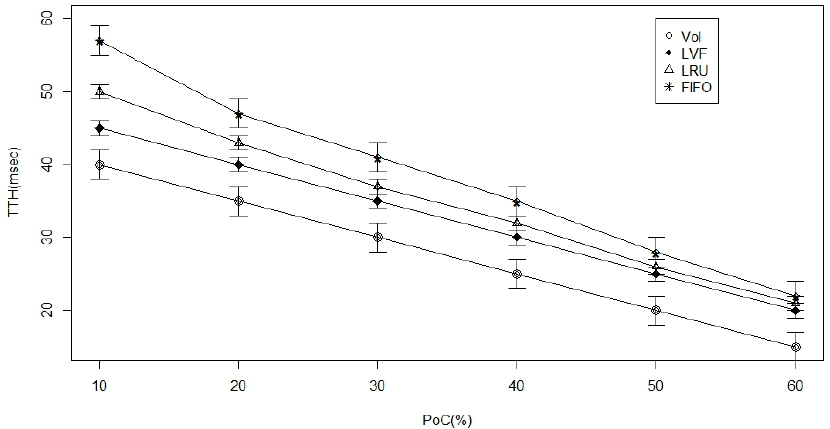
Figure 6. Time-to-hit ratio versus the percentage of nodes with caches in a randomly generated Information Centric Network (ICN)-based Wireless Body Area Network (WBAN).